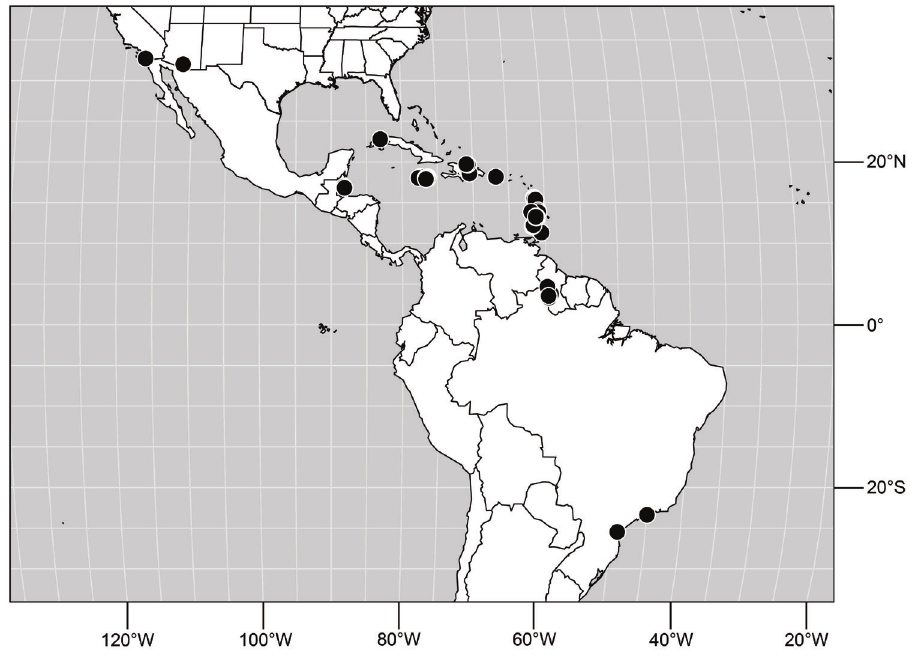
Figure 25. Distribution of Hydrochasma faciale (Williston)